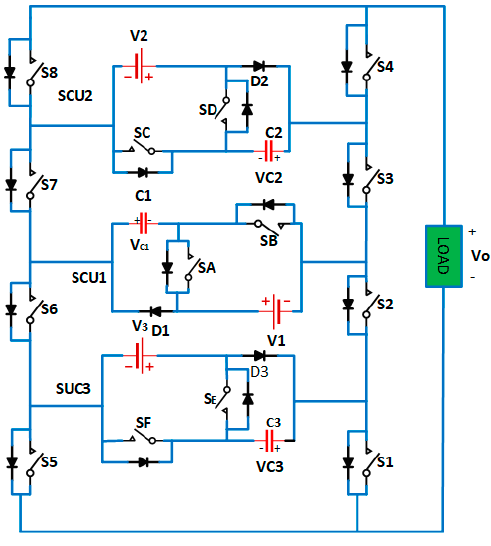
Figure 8. 53 − Level MLI.